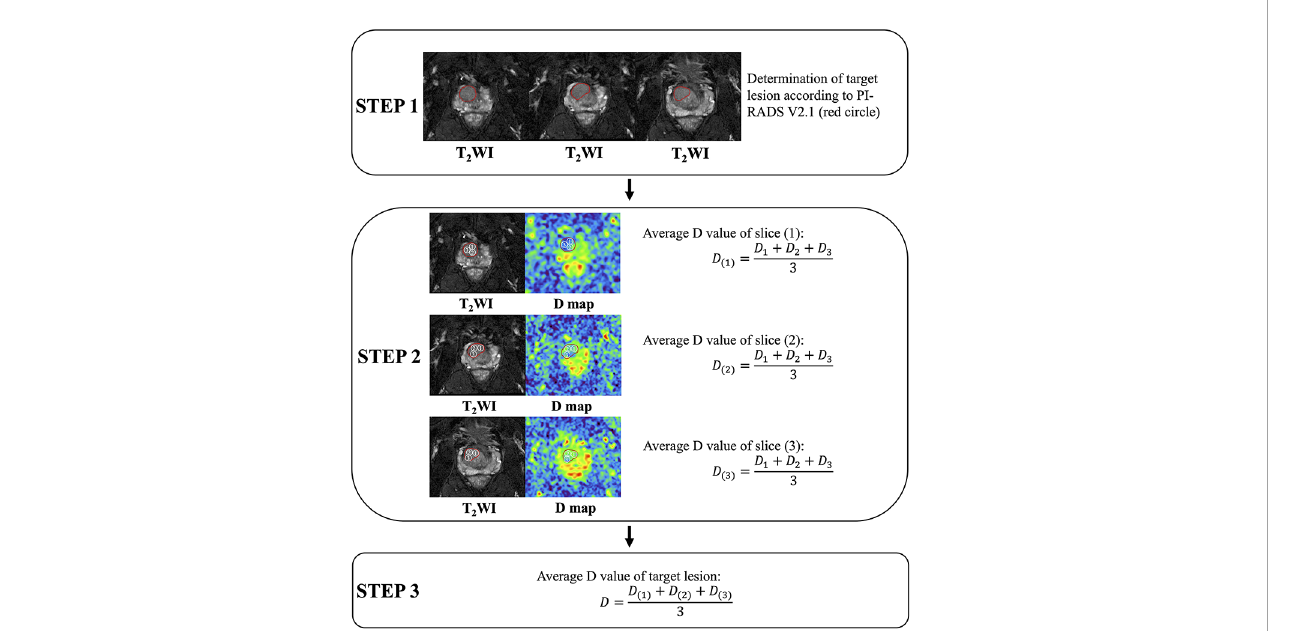
FIGURE 2 Acquisition of quantitative data (carried out on GE AW 4.6 workstation, America, GE Healthcare). Take acquisition of the diffusion coef fi cient (D) value as an example. Step 1. Evaluation of target lesions according to PI-RADS Version 2.1. Step 2. At the maximum 3 slices of the target lesion, measure and calculate the average value of D at each slice. Step 3. Calculating the average D value of the lesion.